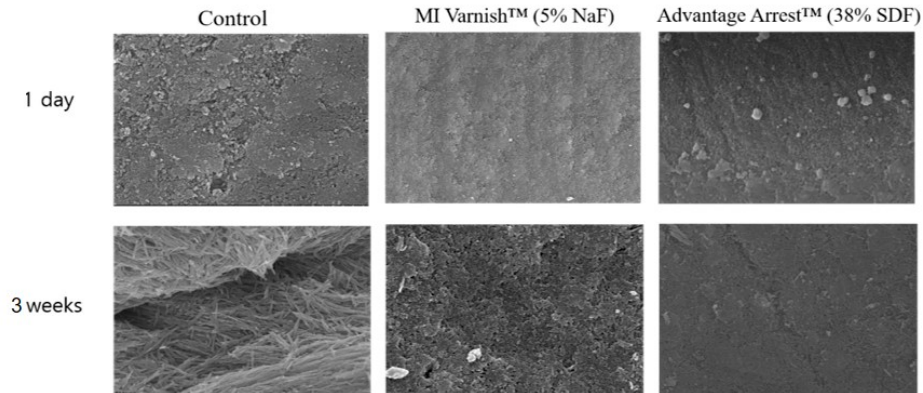
Figure 10. Enamel surface images acquired by scanning electron microscopy (SEM;